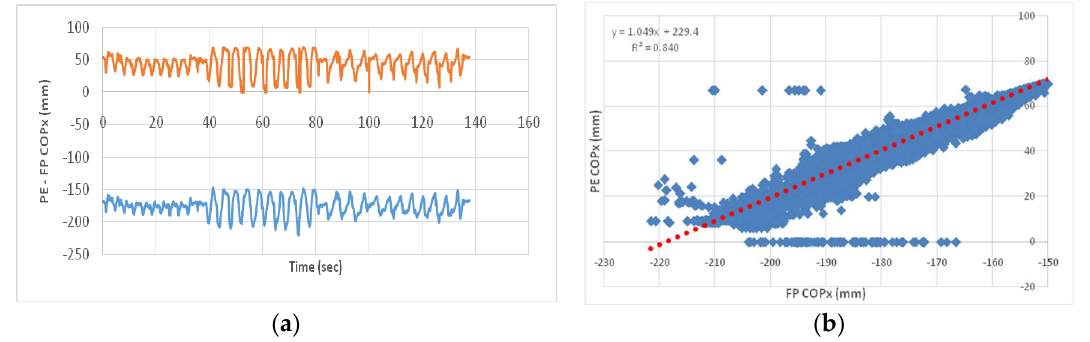
Figure 2. ( a ) COPx of PE (orange) and FP (blue) against time (one participant); ( b ) linear regression fit function for COPx (mm) FP vs COPx (mm) PE (one participant).